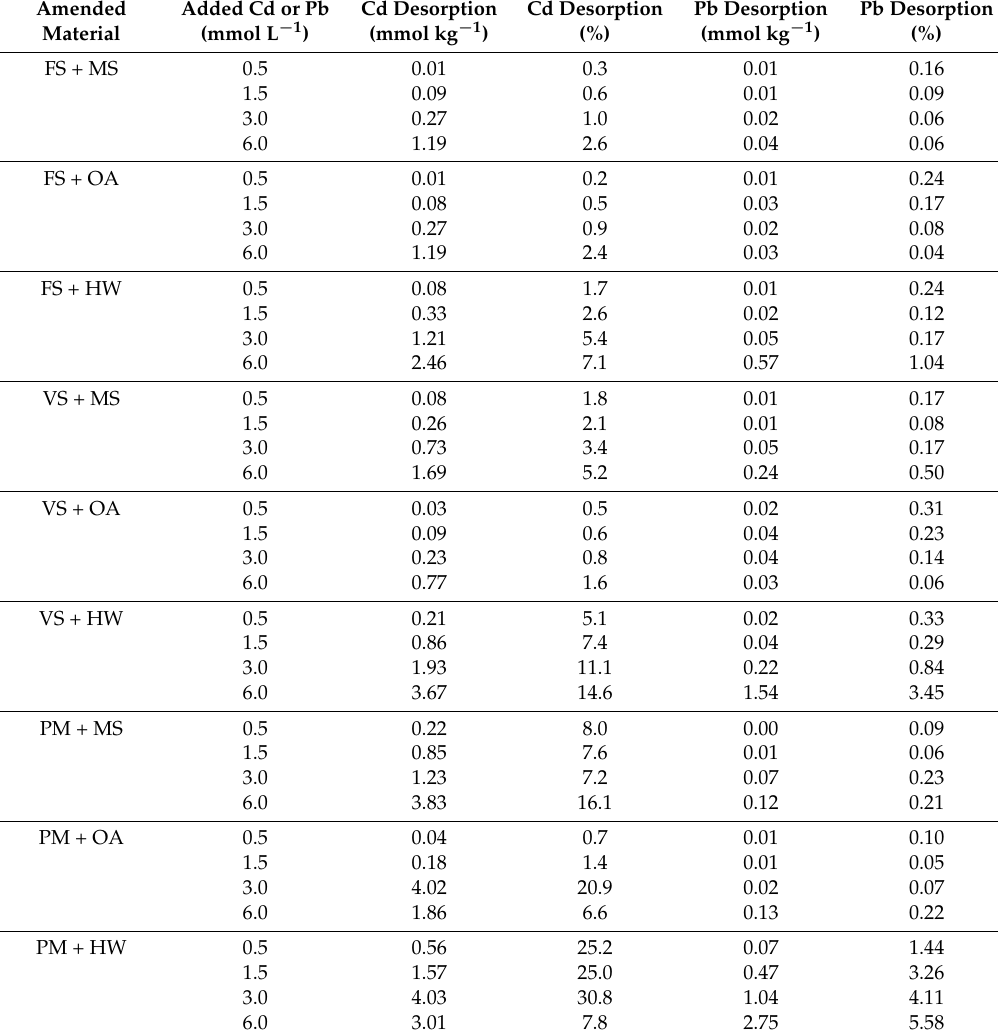
Table 4. Cd and Pb desorption (mmol kg − 1 and %) from the non-amended and waste-amended forest soil, vineyard soil, and pyritic material. Average values for three replicates, with coefficients of variation always